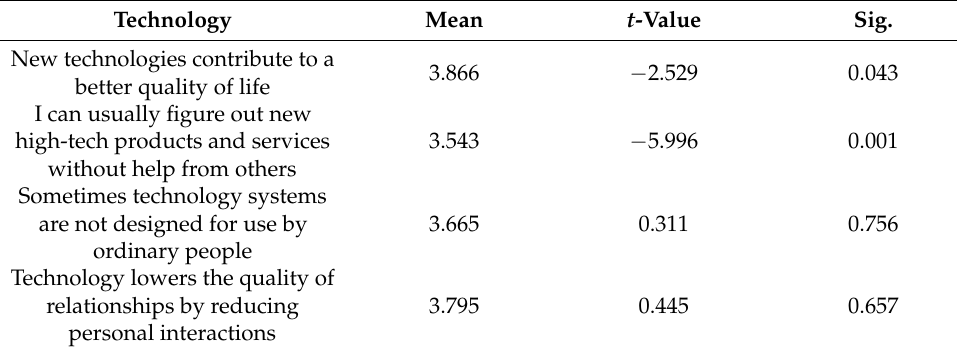
Table 6. Overall level of agreement with the role of